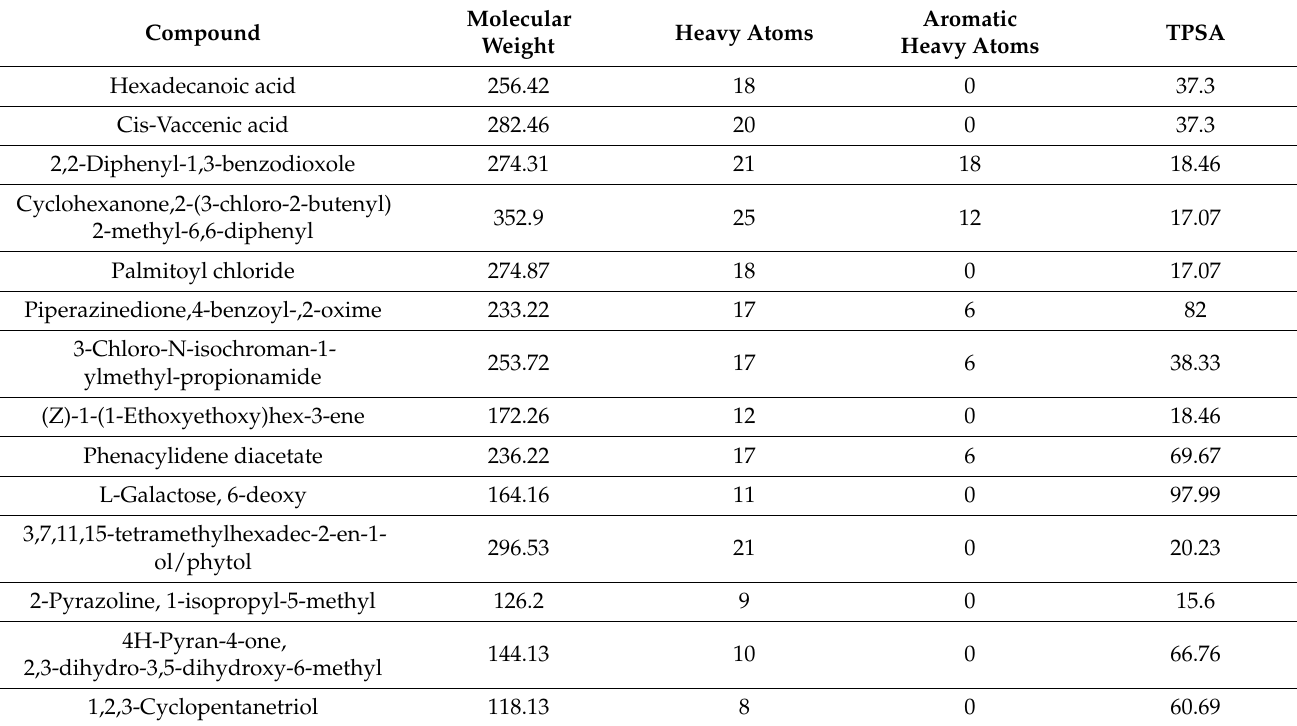
Table 3. Physiochemical properties of the ligand